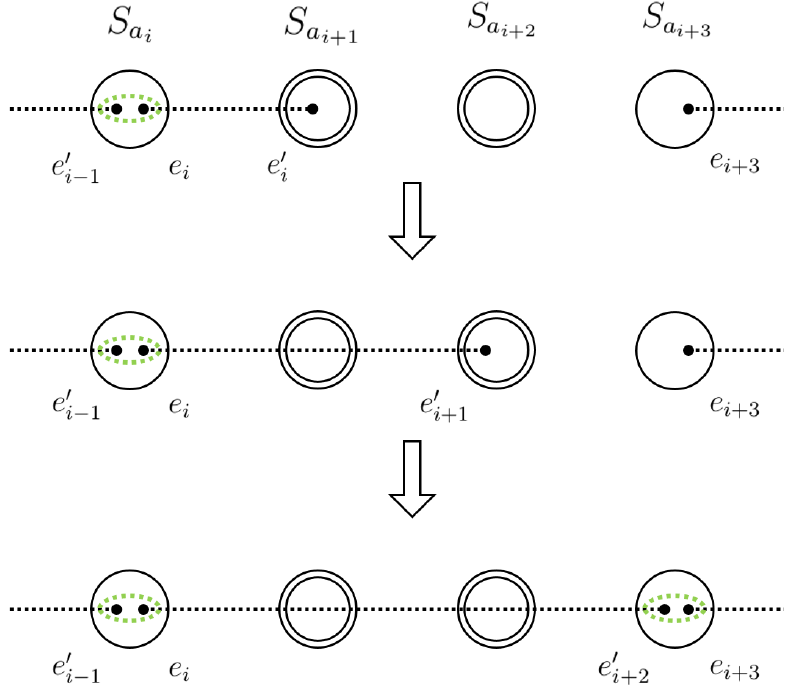
Figure 5. A scenario that involves two inactive quantum switches (concentric circles) between two active ones (circular shapes) on a forward distribution segment. Active quantum switch S a follows the i protocol and sends qubit e (cid:48) to next node S a . The receiver is not part of the chosen subset to create i i + 1 entangled pairs or measure qubits, thus it forwards the particle to S a . The particle is again routed to i + 2 node S a , which is active and can therefore perform a Bell measurement on its i + 3